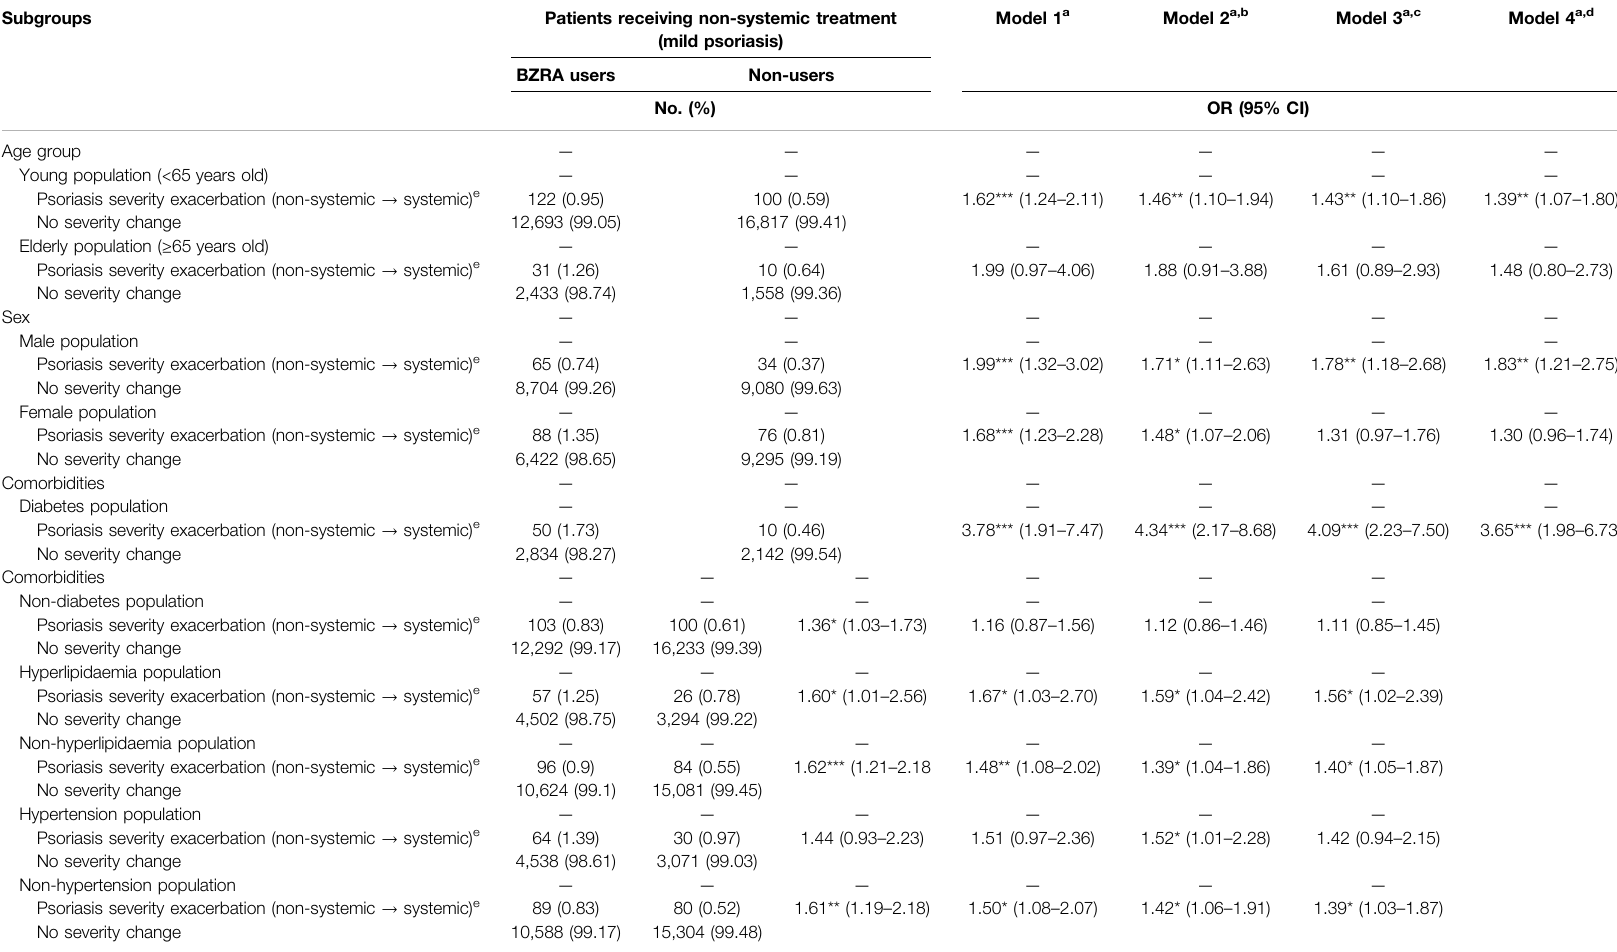
TABLE 4 | Number of patients and risk of psoriasis severity exacerbation between before and after BZRA exposure among different subgroups of patients with mild psoriasis.